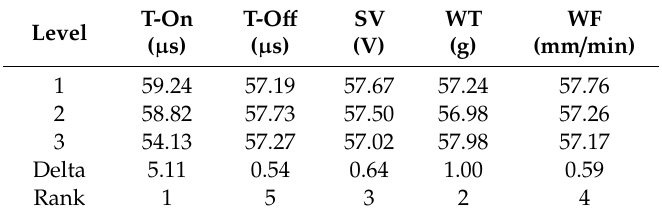
Table 7. S / N ratio analysis of IFH (Larger is better).